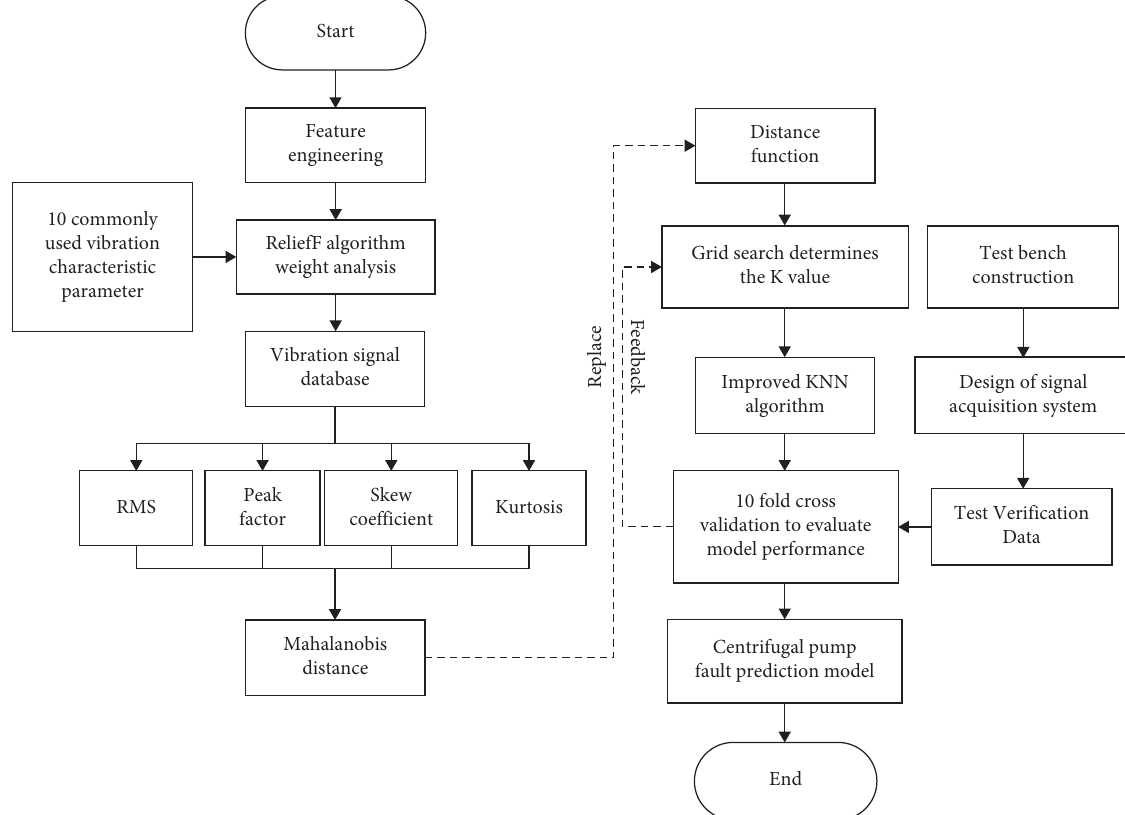
Figure 1: Flowchart of the prediction